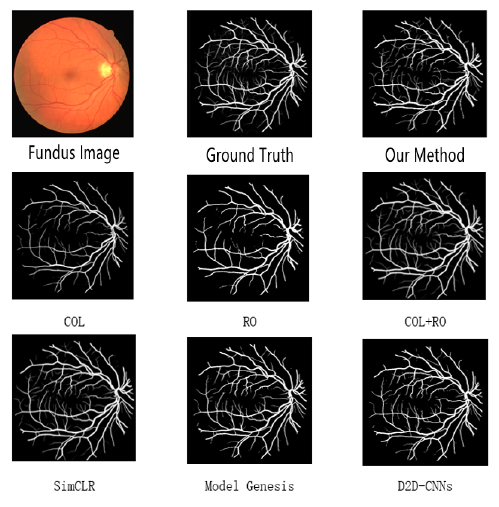
Figure 6. Experimental